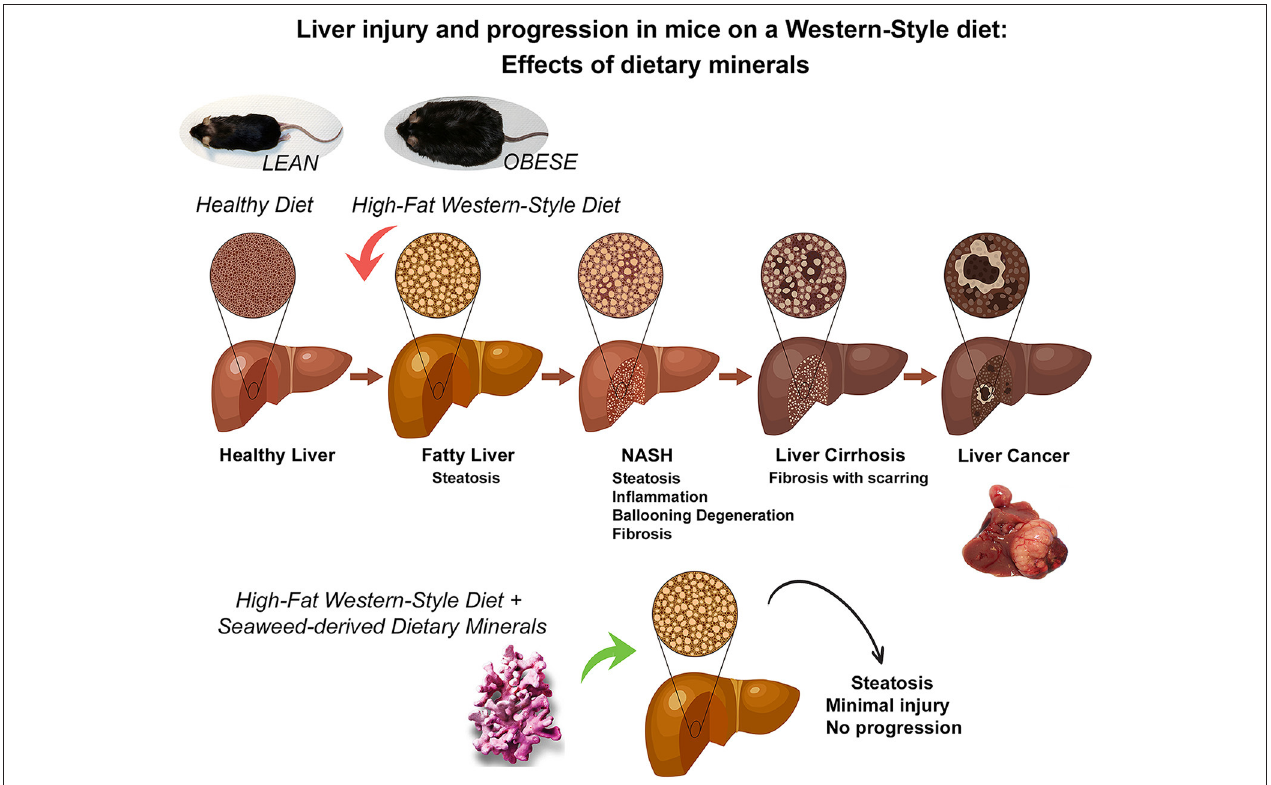
FIGURE 6 | A graphical summary illustrating the mitigating effects of dietary minerals on the high-fat induced liver injury and consequences of liver injury. Some people with non-alcoholic fatty liver disease develop a more aggressive form known as non-alcoholic steatohepatitis (NASH) in which the liver becomes inflamed, develops ballooning degeneration and progresses to fibrosis. In the long-term, this can lead to advanced scarring known as cirrhosis, which can cause liver failure and cancer. However, Aquamin, which is rich in calcium, magnesium and additional minerals and trace elements (derived from calcified red algae), could prevent the adverse downstream effects activated by the high-fat diet (as demonstrated in previous long-term murine studies of up to 18-month and current 16-week mechanistic